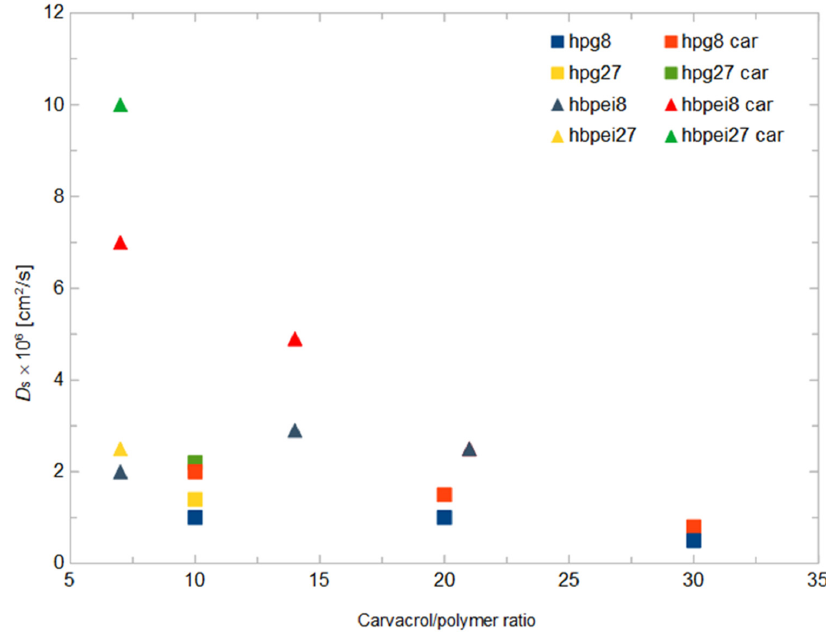
Figure 9. Self-diffusion coefficients ( × 10 6 cm 2 s − 1 ) of polymer (yellow and navy symbols) and carvacrol (red and green symbols) in polymer–carvacrol systems, with respect to carvacrol–polymer ratio.